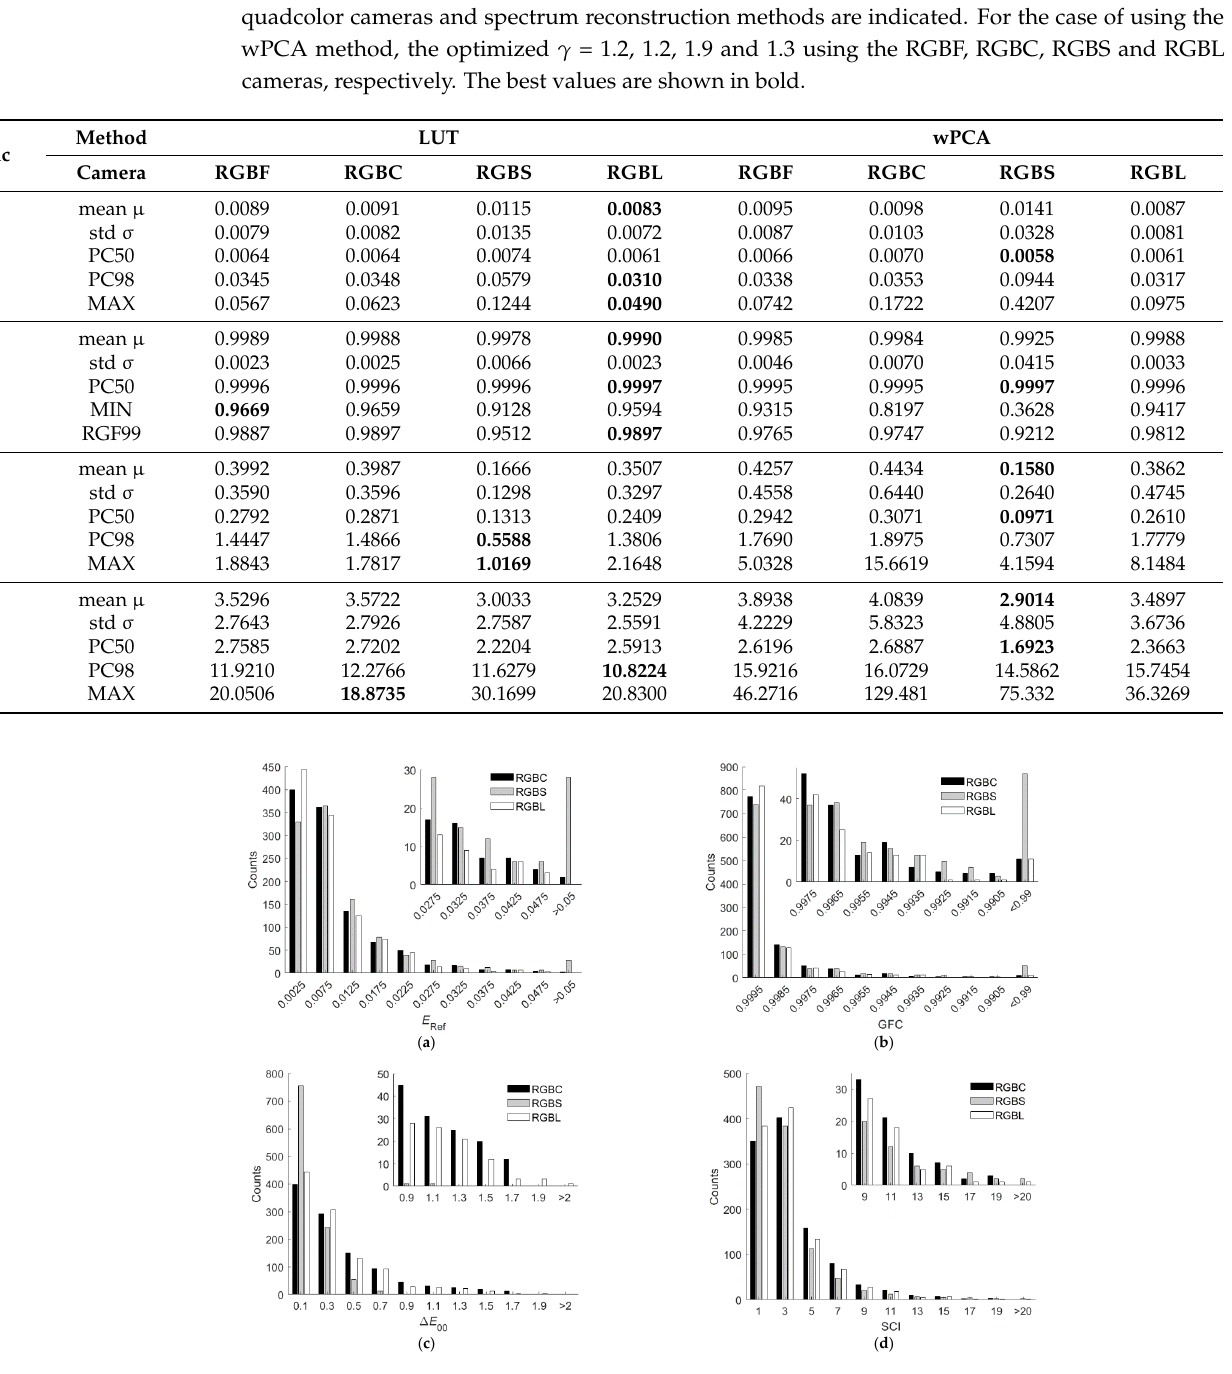
Figure 11. ( a ) E Ref , ( b ) GFC, ( c ) Δ E 00 and ( d ) SCI histograms for the 1066 test samples. The cameras are the optimized RGBC, RGBS and RGBL cameras. Spectra are reconstructed using the LUT method. The insets in ( a – d ) show enlarged parts.